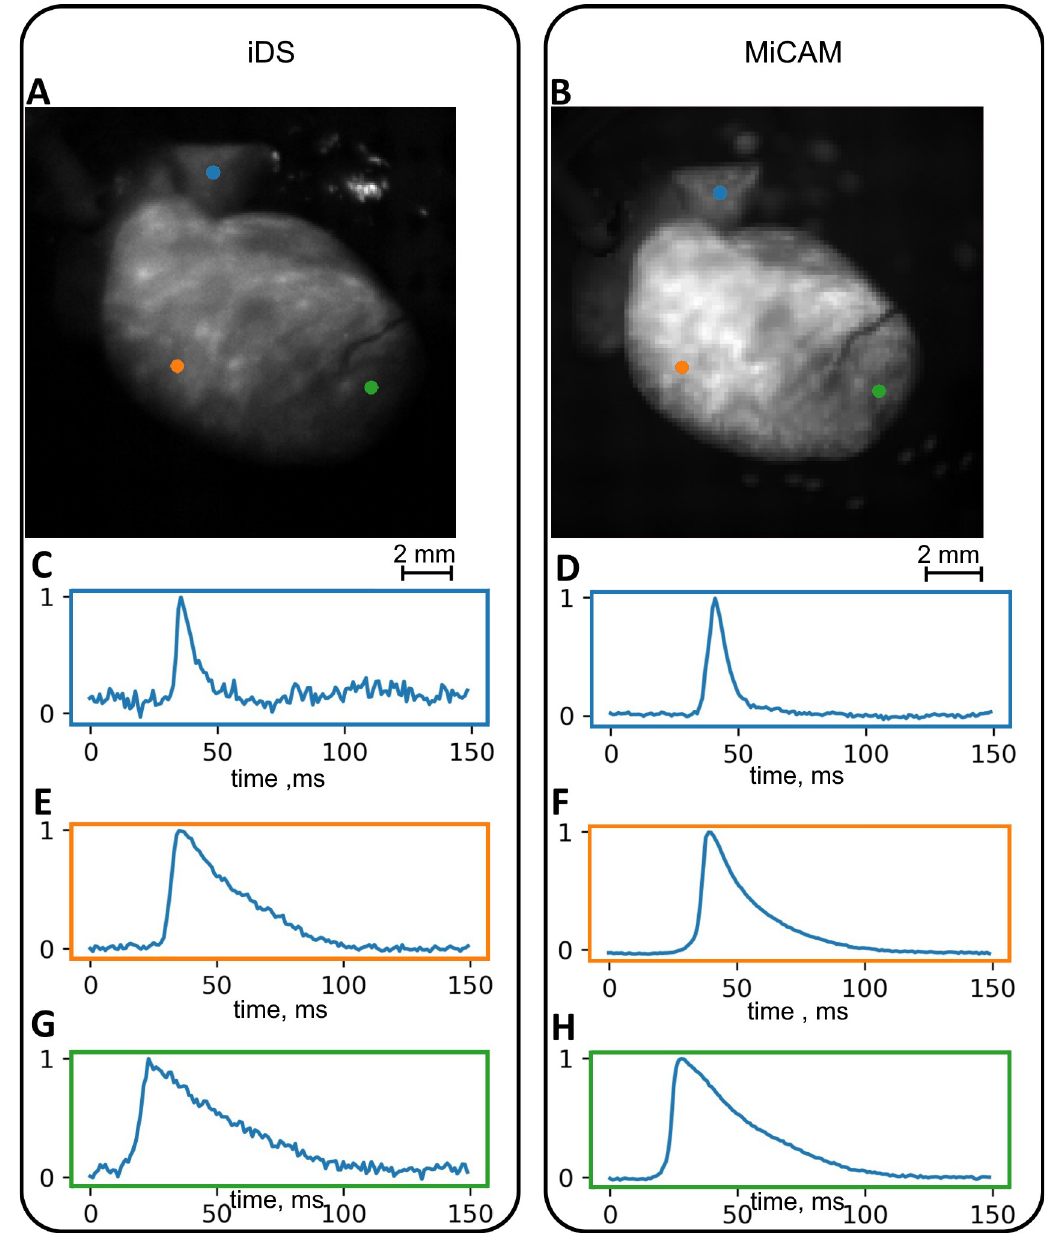
Fig 4. Conditioned signals in optical recordings of a rat heart. (A),(B) Still frames with color-coded pixels corresponding to the AP waveforms. (C),(E),(G) Signals obtained from iDS camera. (D),(F),(H) Signals obtained from the MiCAM